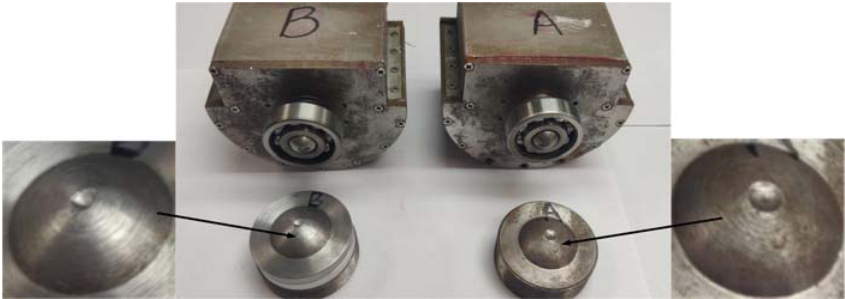
Figure 12. The condition of each component after the impact.